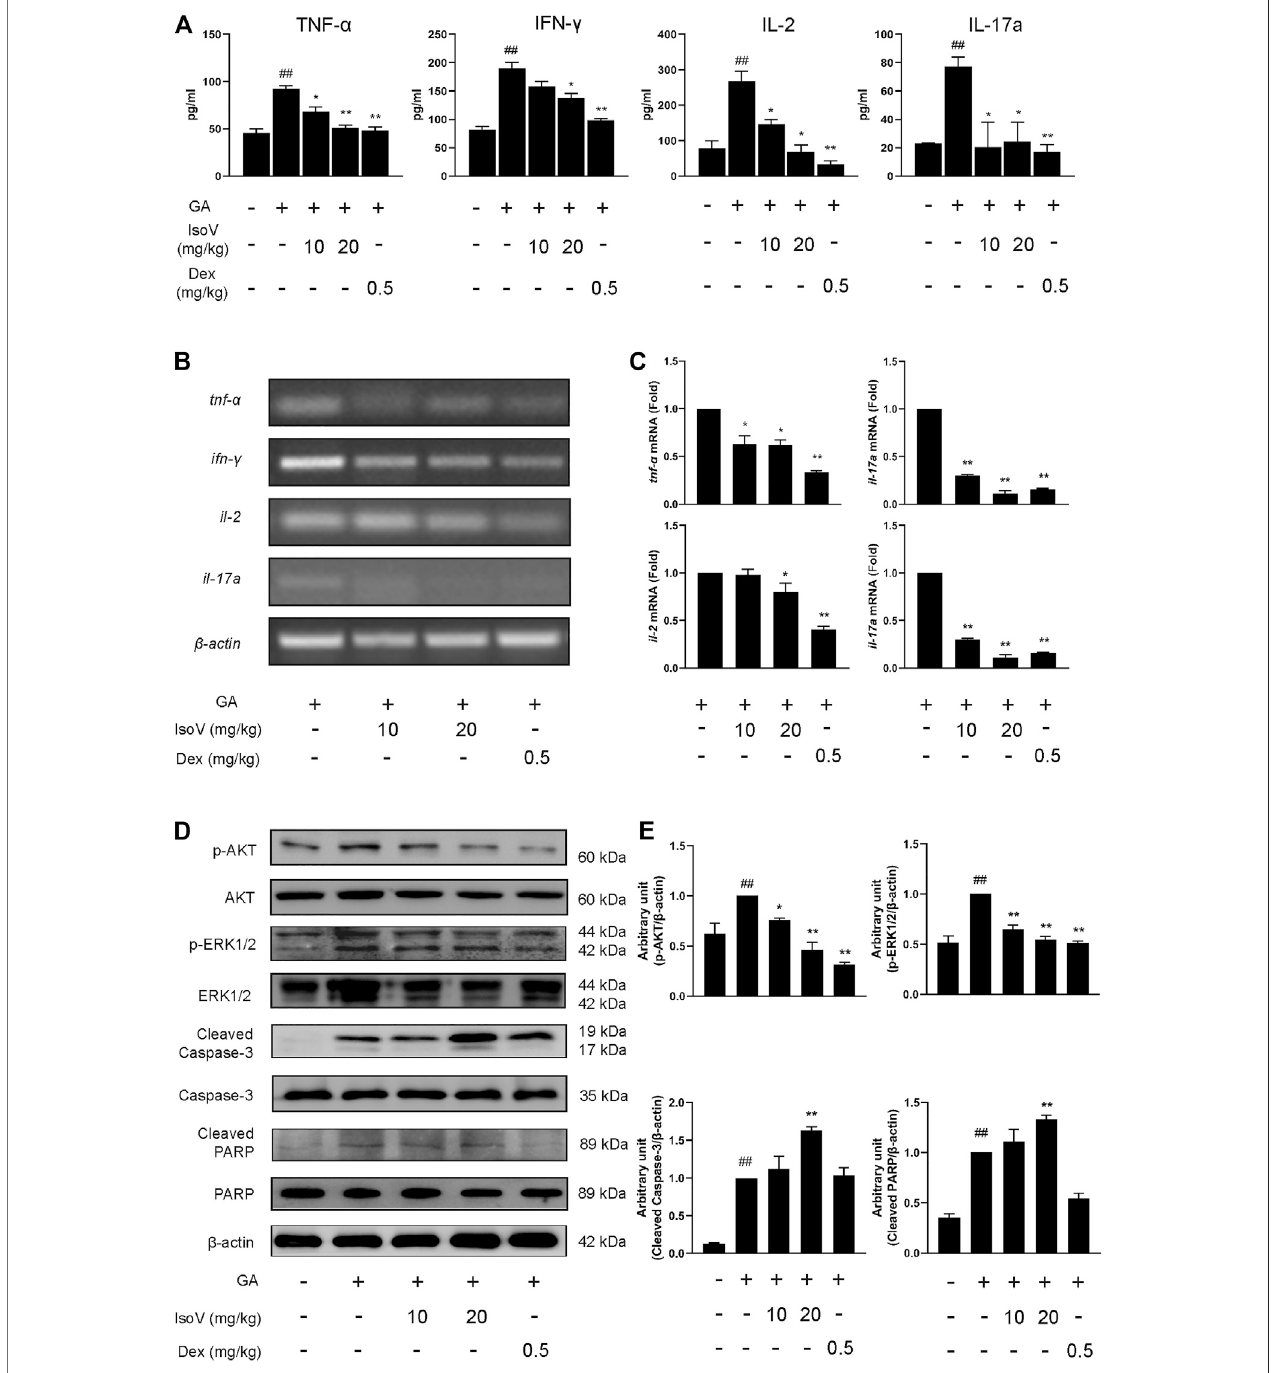
FIGURE 3 | Isovitexin inhibits the expression of pro-in fl ammatory cytokines in lymph nodes and serum from mice with contact dermatitis and promotes the expression ofapoptosis-related proteins. In the mouse model ofGA-induced contact dermatitis, (A) the effect of isovitexin on the levels ofpro-in fl ammatory cytokines in the serum was determined by ELISA. Data are representative of three independent experiments; (B,C) the effect of isovitexin on the in fl ammatory cytokines mRNA expression in lymph nodes was measured by RT-PCR, and the relative band density was analyzed using ImageJ; (D,E) the lymph node cells were harvested and lyzed,andtheeffect ofisovitexinontheprotein levels ofp-AKT, Cleaved PARP,Cleaved Caspase-3, p-ERK1/2 wereanalyzed bywesternblotting,and therelative band density was analyzed using ImageJ. The grouping of gels were cropped from different parts of the different gels. Data represented means ± SEM of three independent time. ## p < 0.01 vs. vehicle group, * p < 0.05, ** p < 0.01 vs. model group.